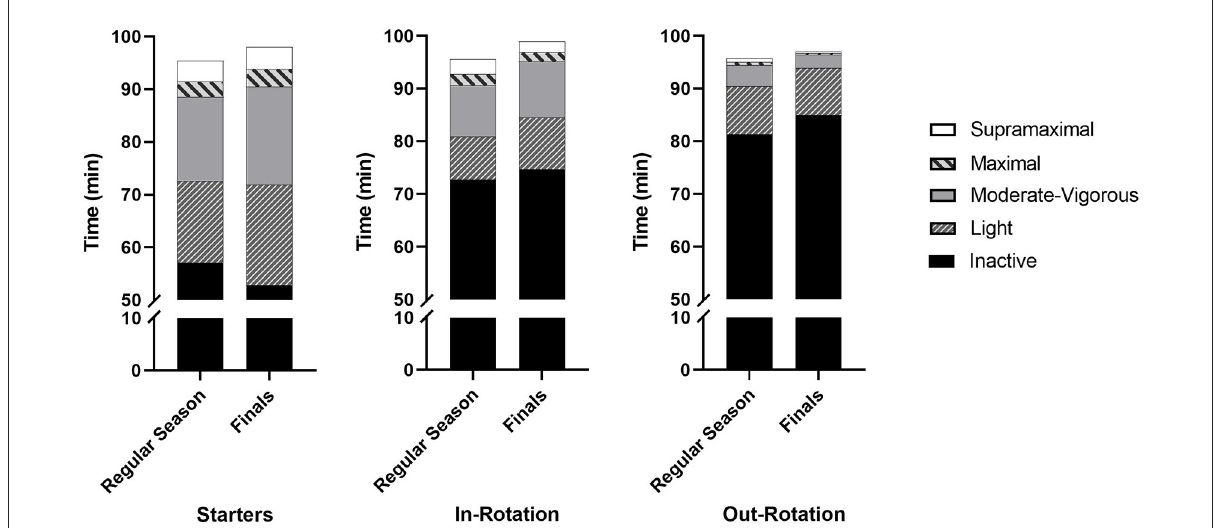
FIGURE1 Absolute match time spent in each intensity band during the regular season and finals for each player